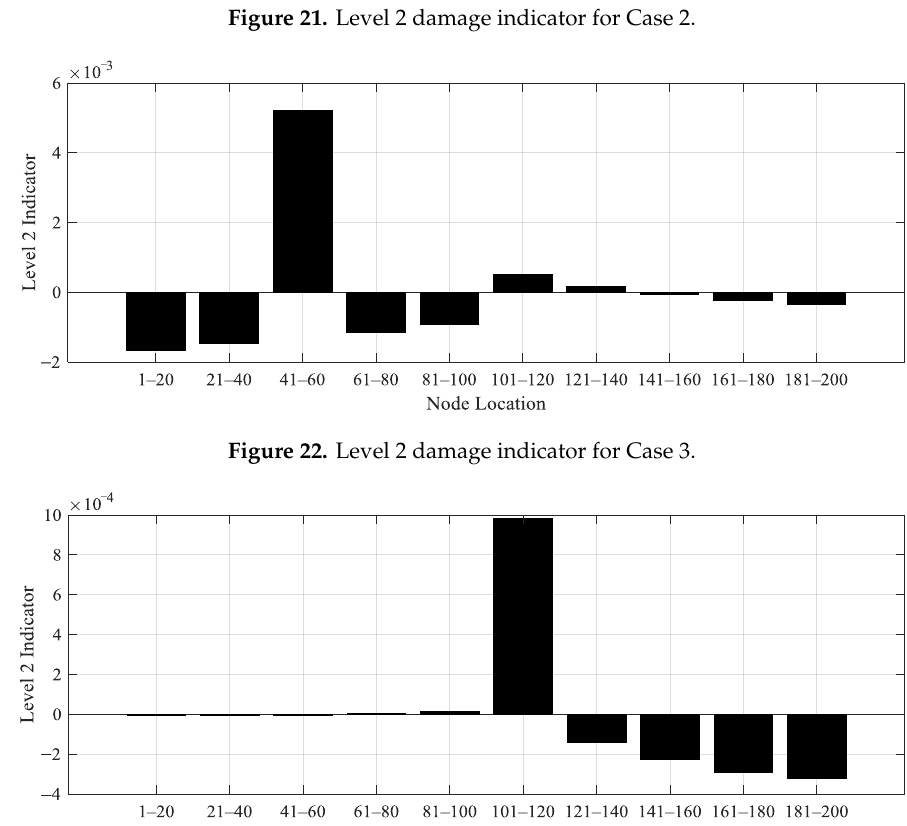
Figure 24. Level 2 damage indicator for Case 5. Figure 25. Level 2 damage indicator for Case 6. 3.3. Full-scale Bridge Experiment A full-scale bridge is used to demonstrate the implementation of the proposed Level 1 damage detecting method. Wenzhou Bridge, located in Taipei city, is selected as the test bridge because it is an important bridge, and the riverside park under the bridge provides test personnel to facilitate the assembly of test equipment. Wenzhou bridge is constructed in the Year 2000. It is a prestressed girder bridge with four lanes. No damage is visually detected before our testing. The experiments are initiated at the beginning of April 2020, and field data are continuously collected until now. Due to